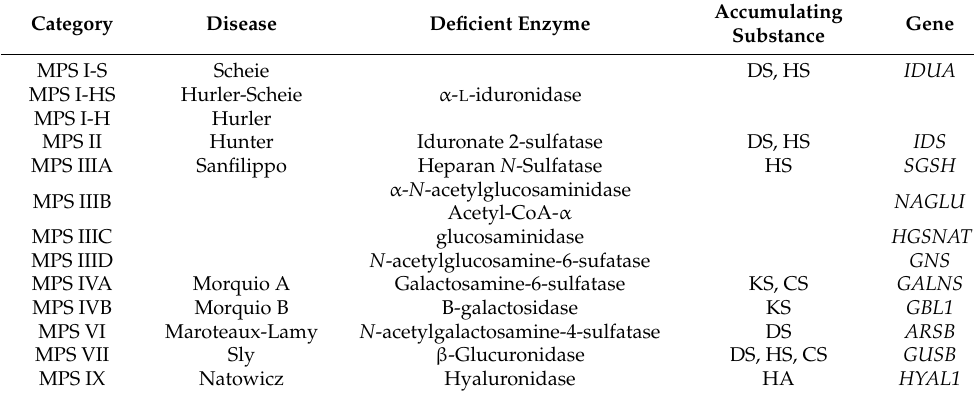
Table 1. Classification of MPS